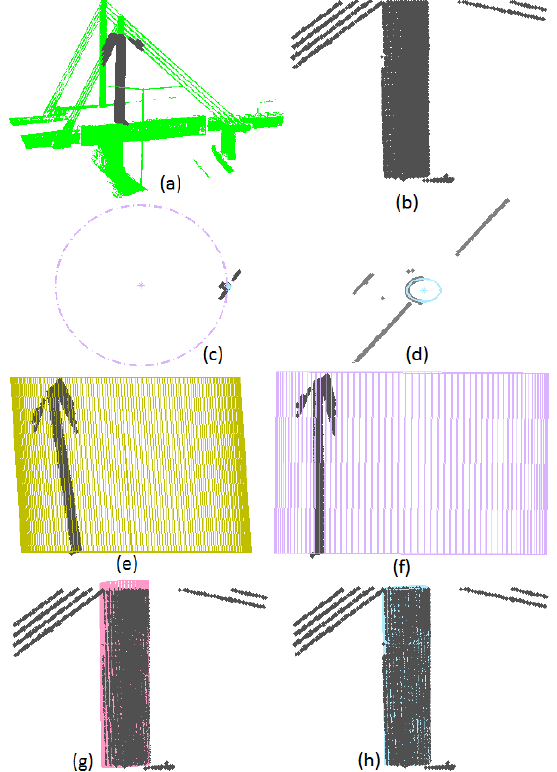
Figure 7. Cylinder fitting for bridge-pole data; (a) bridge-pole data in a scene, (b) bridge-pole for cylinder fitting, (c) fitted circles for Lalonde (bigger one) and RLTS onto the 2D RPCA based plane, (d) 2D points and fitted circle by RLTS, (e) fitted cylinder (olive) for the LS with real points (black), (f) fitted cylinder (violet) for Lalonde, (g) fitted cylinder for RANSAC Figure 6. Cylinder fitting for signpost data; (a) signpost data, (pink), and (h) fitted cylinder (feroza) for RLTS (b) 3D PCD for cylinder fitting, (c) top view of the cylinder data, (d) fitted circles for Lalonde and RLTS, (e) fitted cylinder for LS with real points (black), (f) fitted cylinder for Lalonde, (g) fitted cylinder for RANSAC, (h) fitted cylinder for RLTS, and (i) all the fitted cylinders from different methods in a same figure Table 5. Estimated radii (m) and lengths (m) of the fitted cylinders from different methods for bridge-pole